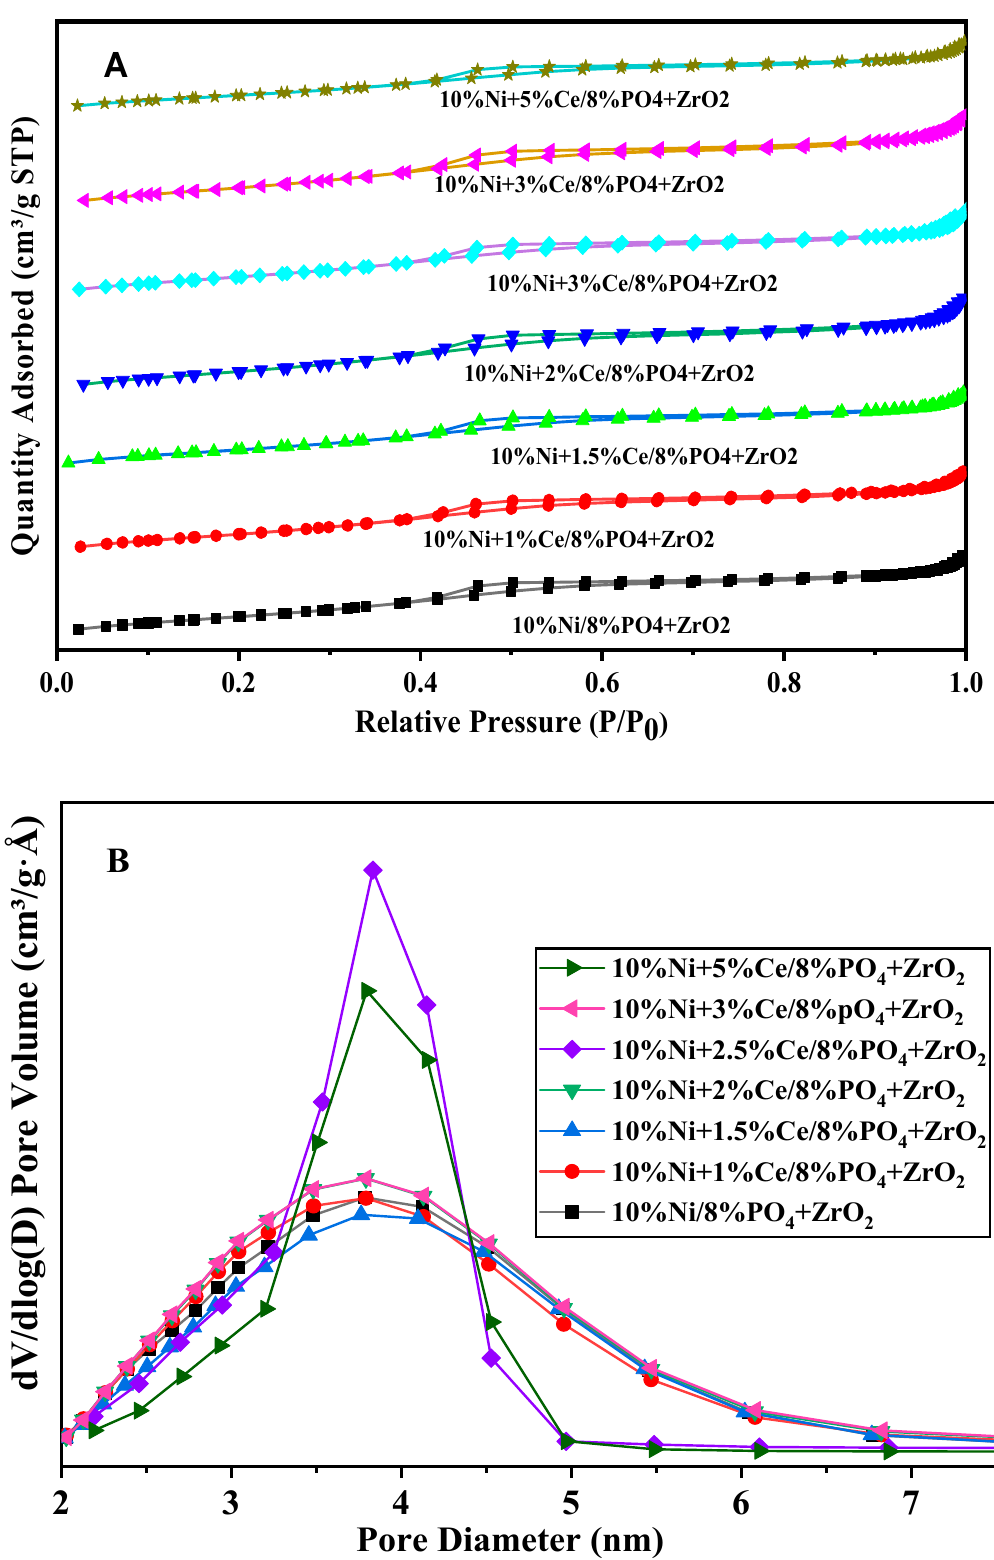
Figure 1. Nitrogen adsorption–desorption isotherms ( A ) and pore size distribution ( B ) diameter of fresh catalysts calcined at 600 ◦